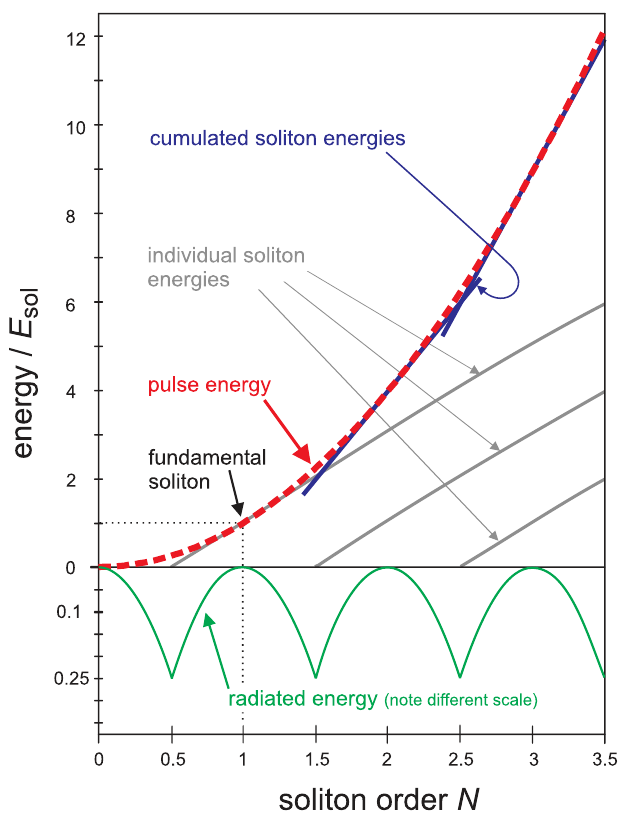
Figure 3. Soliton and radiation energies as a function of soliton order N . Energy is normalized to units of fundamental soliton E sol of Equation (5). The fundamental soliton is at the black dotted markers. Individual soliton energies (grey lines) add up to a cumulative value (piecewise linear blue trace); the latter approximates the total pulse energy (red dashed parabola). The difference between both is shown on an expanded, inverted scale in the lower part (green curve). From